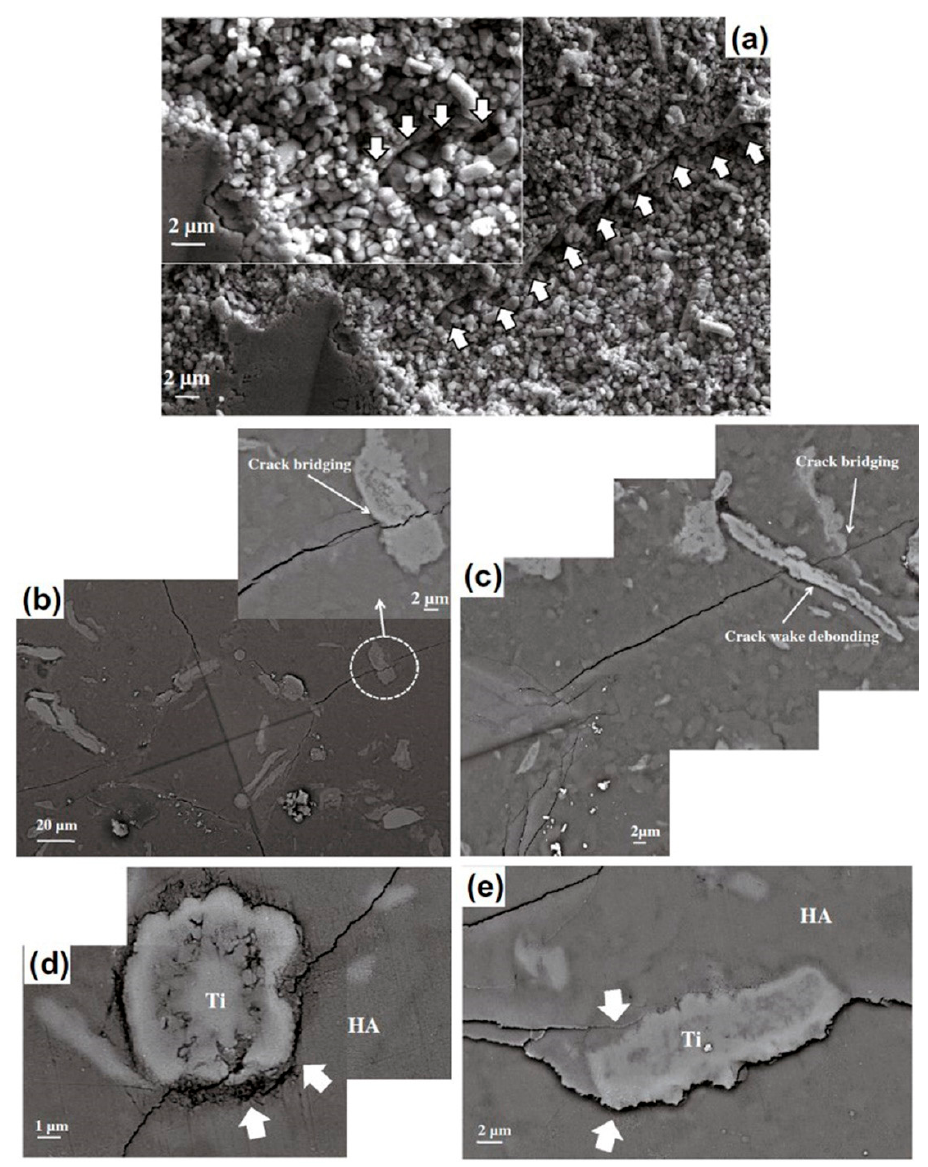
Figure 10. Representative secondary electron SEM micrographs of chemically etched HA ( a ), showing the indent (500 g load) region and crack path (marked with a white arrow); ( b , c ) represent the backscattered electron SEM images of HA-10 Ti, showing the indent (at 1000 g load) region and crack path. The crack bridging (marked on ( b , c )) by lath-shaped/elongated Ti particles and crack wake debonding (marked on ( c )) are visible. The crack wake debonding at the HA/Ti interface with spherical and lath-shaped particles is clearly visible and marked with white arrow on ( d , e ), respectively [31].